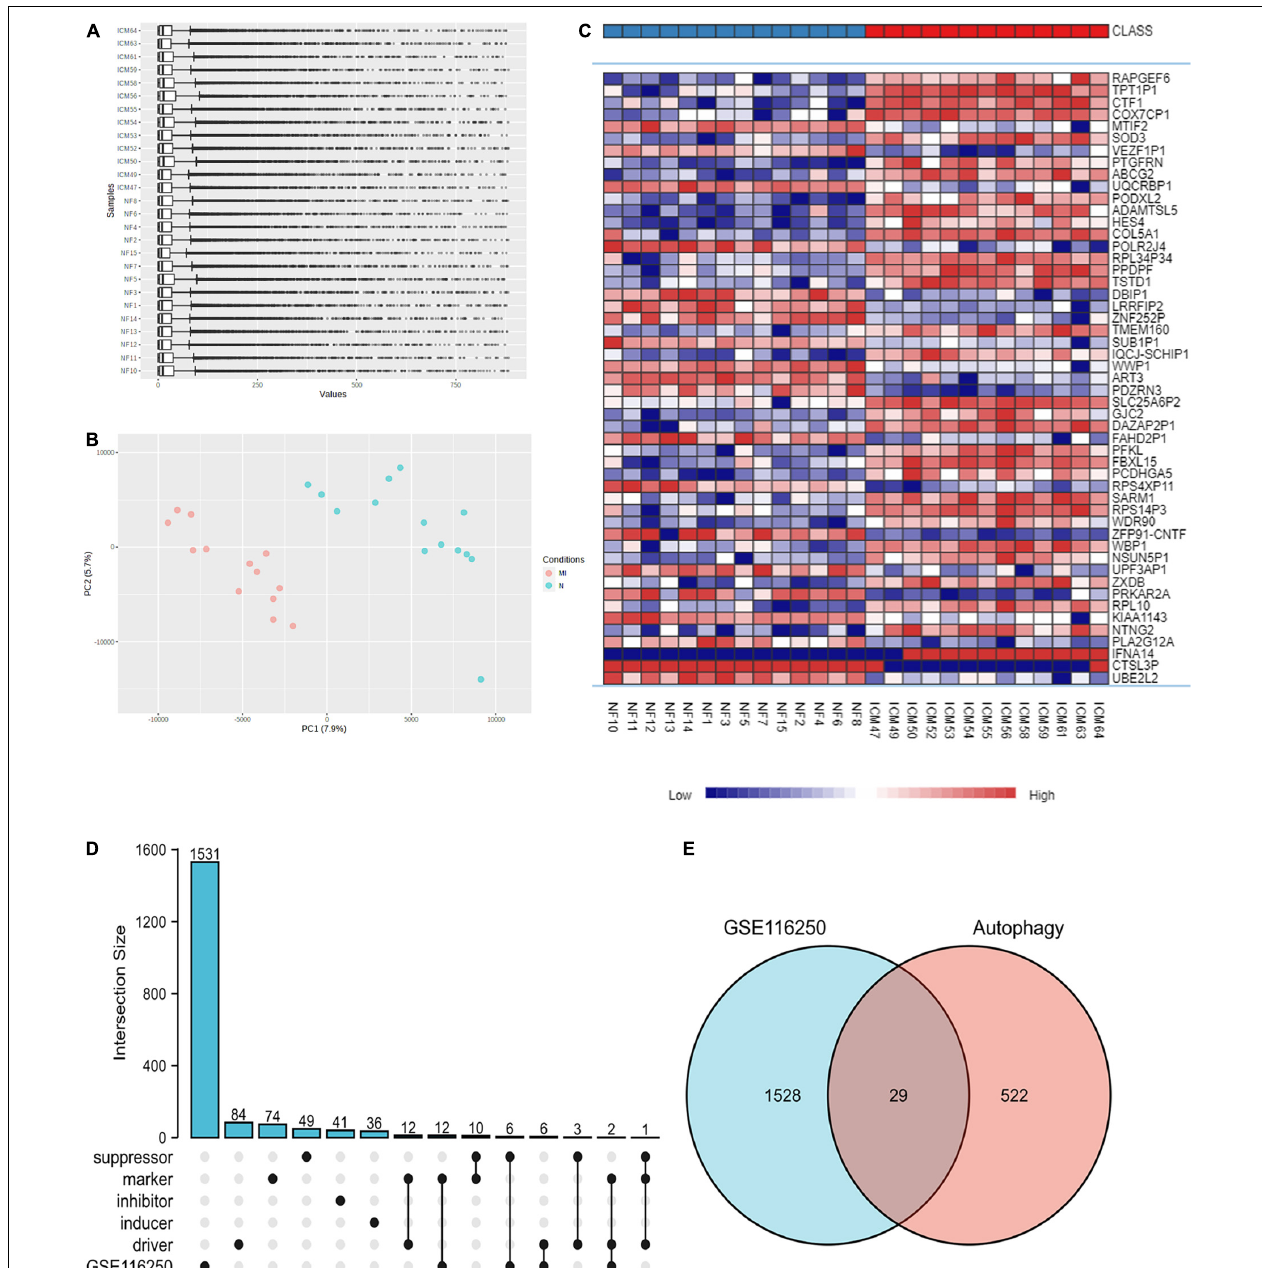
FIGURE 1 | Identification of DEGs in the ischemic myocardiopathy GEO dataset. (A) The normalization of the ischemic myocardiopathy dataset was applied through Log2 Transformation. (B) The gene cluster in PCA loading score. MI, ischemic myocardiopathy; N, control. (C) The heat map of the dataset demonstrated distinguished features between ischemic myocardiopathy and control heart samples. (D) An Upset diagram ofGSE116250 DEGs as well as ferroptosis driver, inducer, inhibitor, marker, and suppressor. (E) A Venn diagram of GSE116250 DEGs and autophagy-related genes.